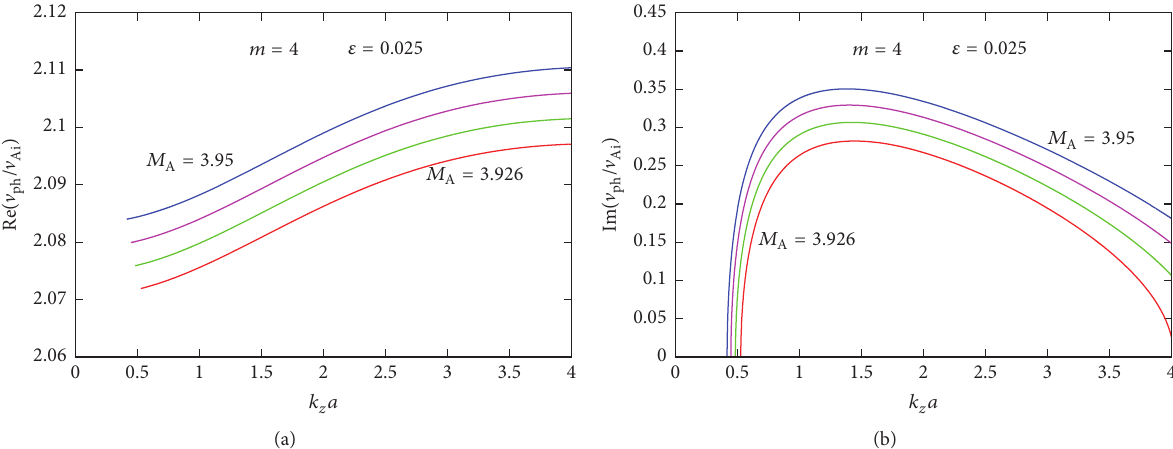
Figure 7: (a) Dispersion curves of unstable ( 𝑚 = 4 ) MHD mode propagating in a moving twisted flux tube of incompressible plasma at the same parameters as in Figure 6 for 𝑀 A = 3.926 , 3.934 (green curve), 3.942 (purple curve), and 3.95. (b) The normalized growth rates for the same values of 𝑀 A